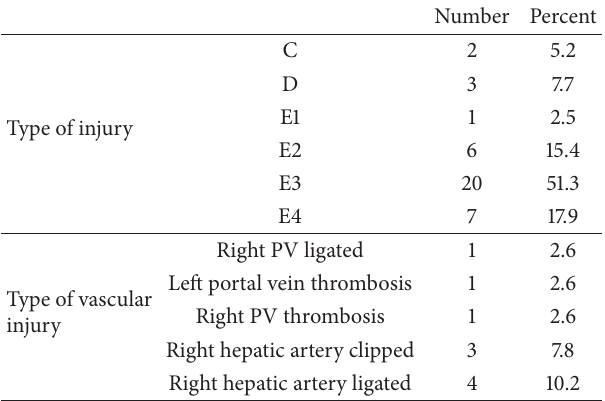
Table 2: Biliary and vascular injuries.